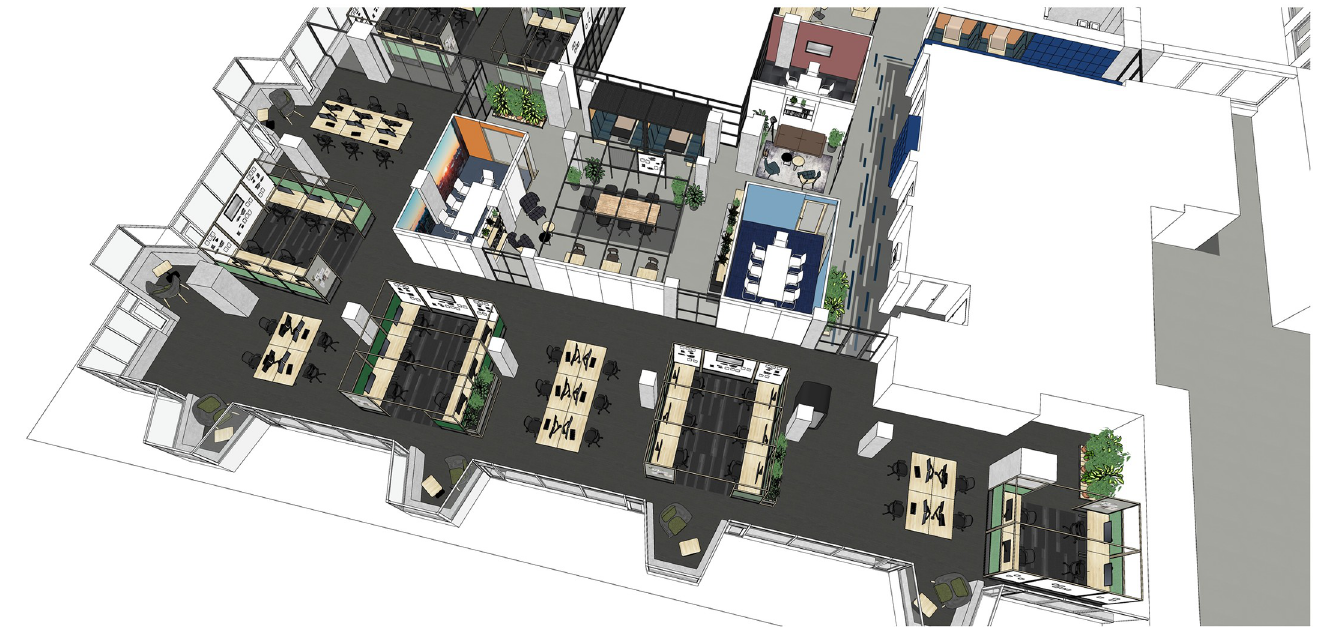
Fig 6. Team office design. Digital render of the Team office design.